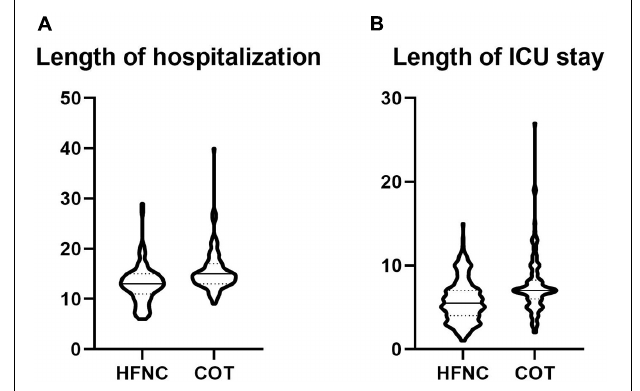
FIGURE 3 | Comparison of (cid:49) GCS between two